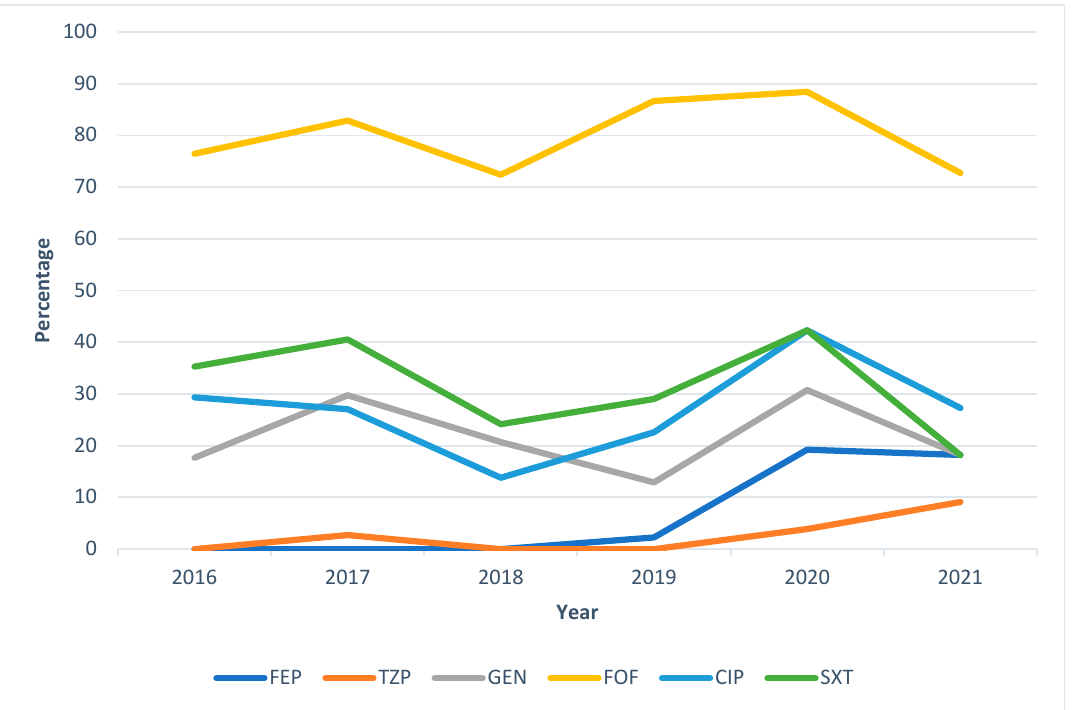
Figure 2. General annualized resistances (%) of Morganella morganii between 2016 and 2021 against the antibiotics most frequently used to treat UTIs. FEP = cefepime; TZP = piperacillin–tazobactam; FOF = fosfomycin; SXT = trimethoprim–sulfamethoxazole.